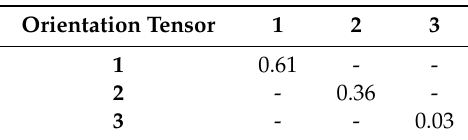
Figure 1. Generated fiber network of unit-cell. Table 1. Components of orientation tensors used for the generation of microstructures for verification of Fourier series.